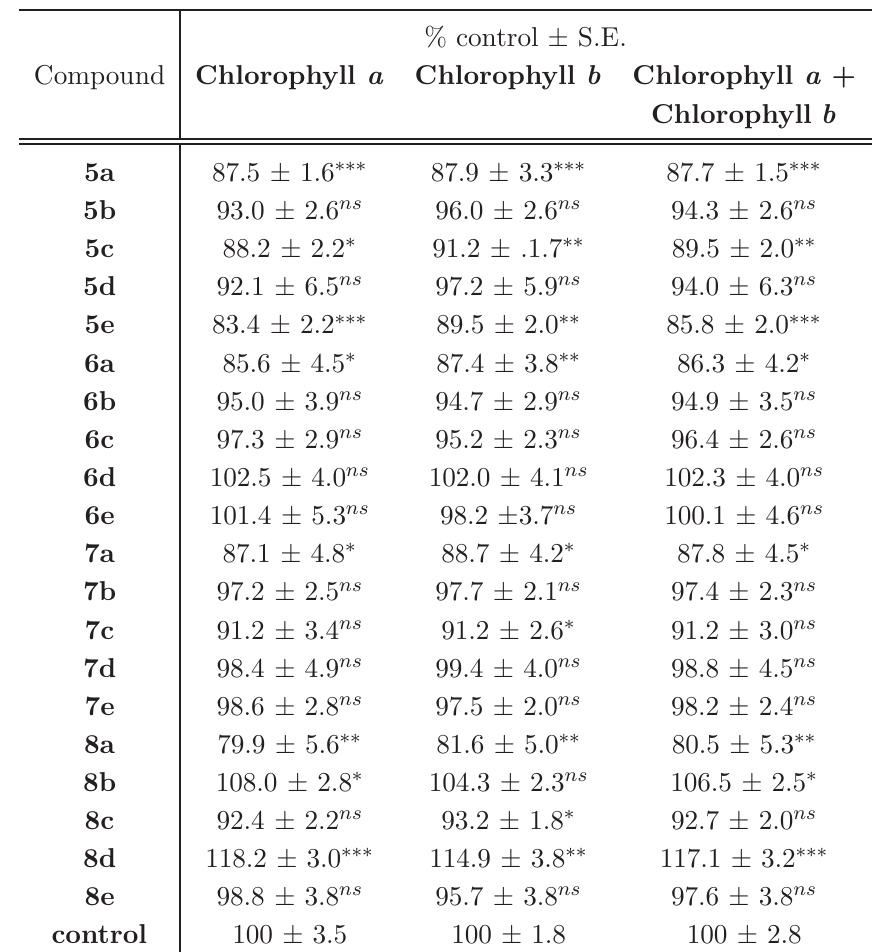
Table 3 The effect of compounds 5 - 8 on chlorophyll content in algal suspensions of Chlorella vulgaris. S. E. =standard error; * significant difference at P = 0.05; ** significant difference at P = 0.01; *** significant difference at P = 0.001; ns = non